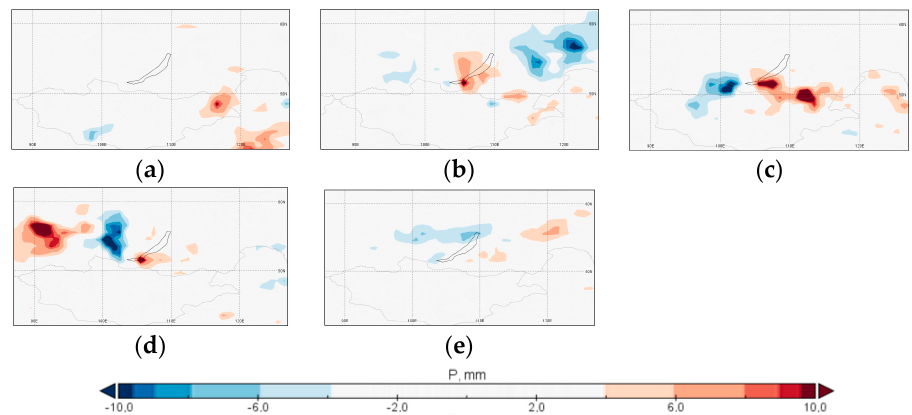
Figure 3. The difference in precipitation between two periods (1982–1998 and 1999–2019). ( a ) M1, ( b ) SES-M2, ( c ) SES-M1, ( d ) SES2, ( e ) SES 1. Negative values (blue) correspond to location maxima in 1999–2019, and positive values (red) in 1982–1998.